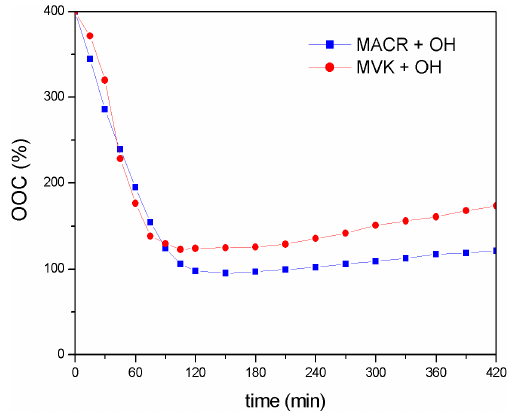
Fig. 8. Total organic carbon balance from the OH-oxidation of MACR and